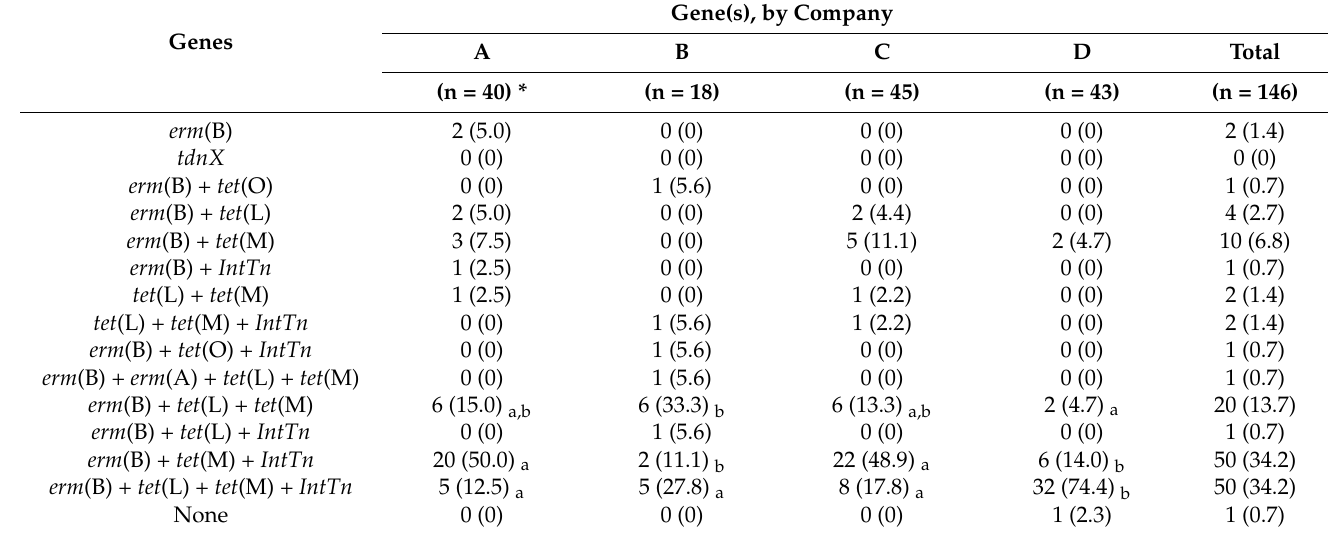
Table 2. Distribution of antimicrobial resistance genes and transposon genes in tetracycline- and erythromycin-resistant Enterococcus faecalis and Enterococcus faecium in bulk tank milk from four dairy